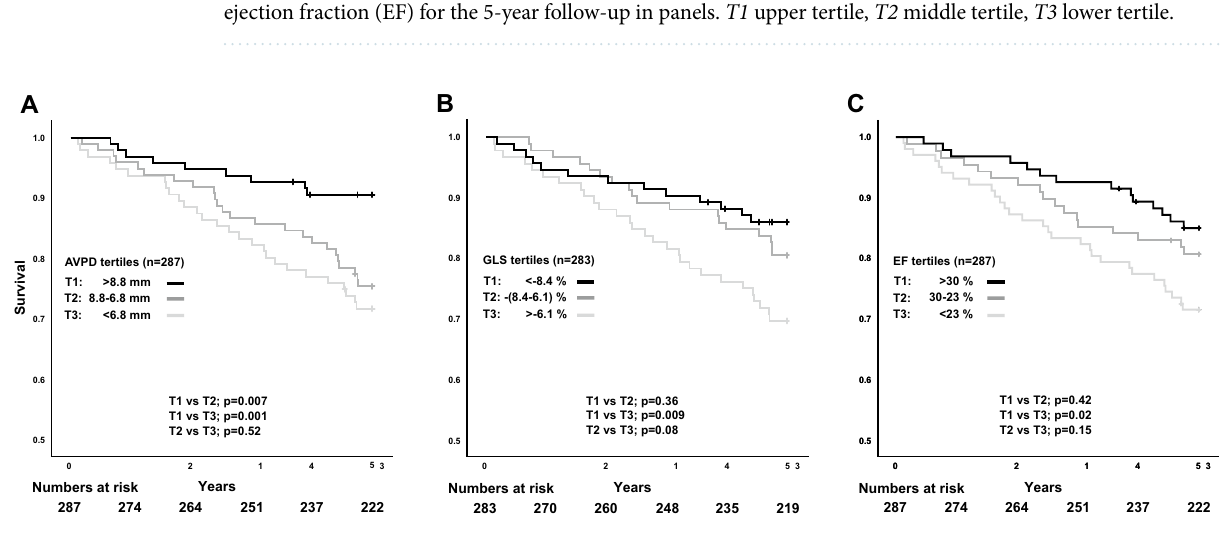
Figure 3. All-cause death. Kaplan–Meier curves showing survival from all-cause death stratified by tertiles for ( A ) atrioventricular plane displacement (AVPD), ( B ) global longitudinal strain (GLS) and ( C ) ejection fraction (EF) for the 5-year follow-up. T1 upper tertile, T2 middle tertile, T3 lower